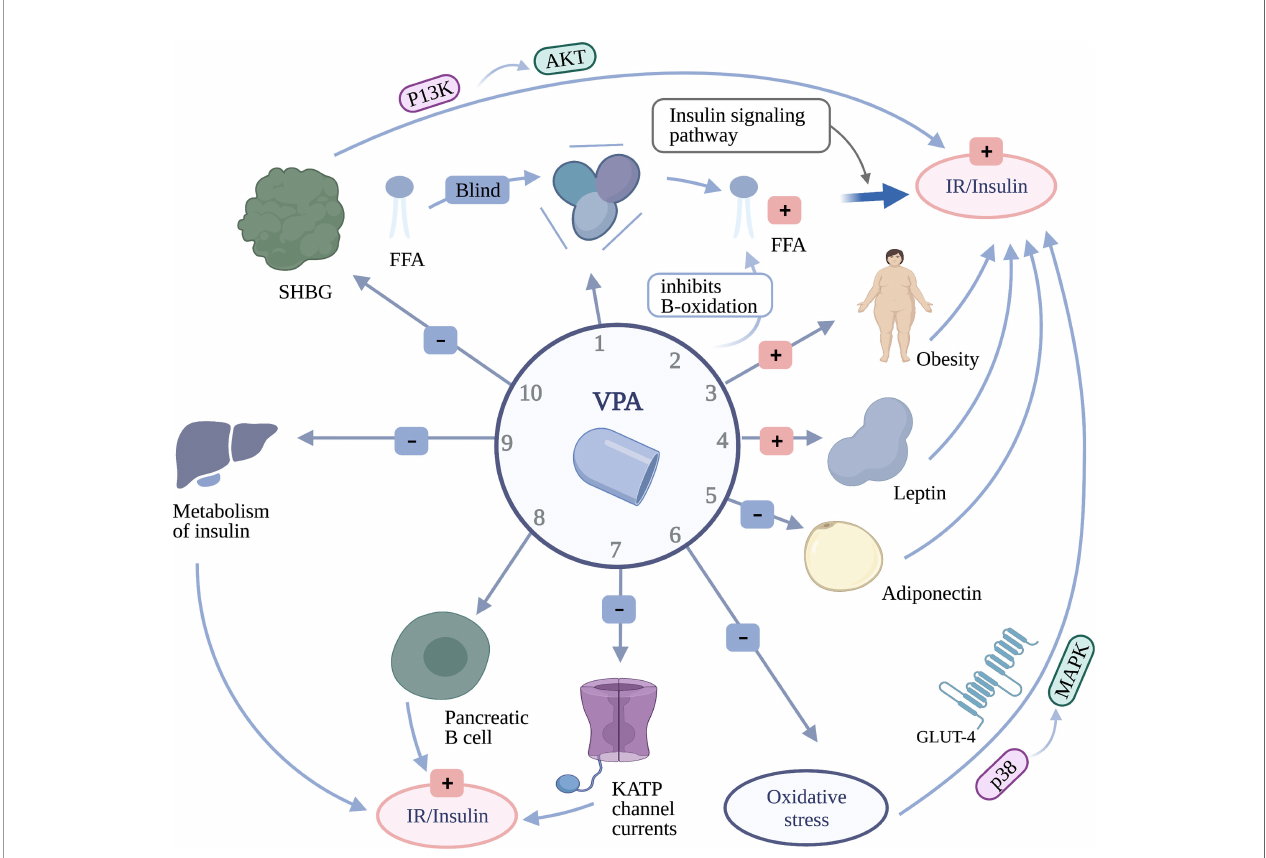
FIGURE 3 | The mechanism of insulin resistance or hyperinsulinemia caused by valproate (VPA). 1 VPA can compete with free fatty acids (FFAs) for binding to albumin to increase the availability of FFAs, which can induce insulin resistance (IR) through the insulin signaling pathway. 2 VPA elevates the level of androgen by inhibiting the B-oxidation of FFAs. 3 Obesity promotes the occurrence of IR. 4 High leptin levels are closely related to IR. 5 The reduction of adiponectin is signi fi cantly related to IR. 6 VPA hinders oxidative stress, which can in fl uence IR through the p38 MAPK signaling pathway and reduce the expression of glucose transporter 4 (GLUT-4). 7 VPA can attenuate K-ATP channel currents, which can then regulate the membrane potential of B cells, leading to increased insulin secretion. 8 VPA can directly act on pancreatic B cells to increase insulin secretion. 9 VPA could affect the metabolism of insulin in the liver, which can bring about an increase in insulin concentrations. 10 Refers to the level of sex hormone binding globulin (SHBG), which has an impact on the level of IR by regulating the PI3K/AKT signaling